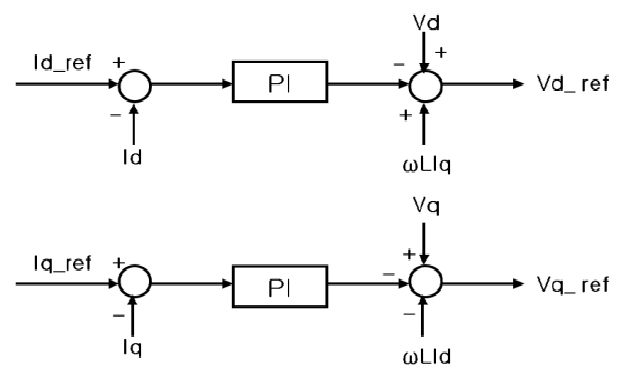
Figure 6. Block diagram of current controller.